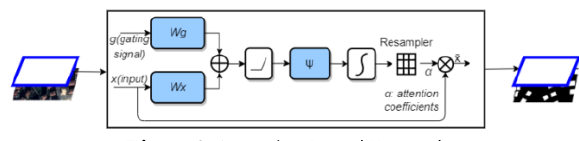
Figure 6 . Attention-Based Network.